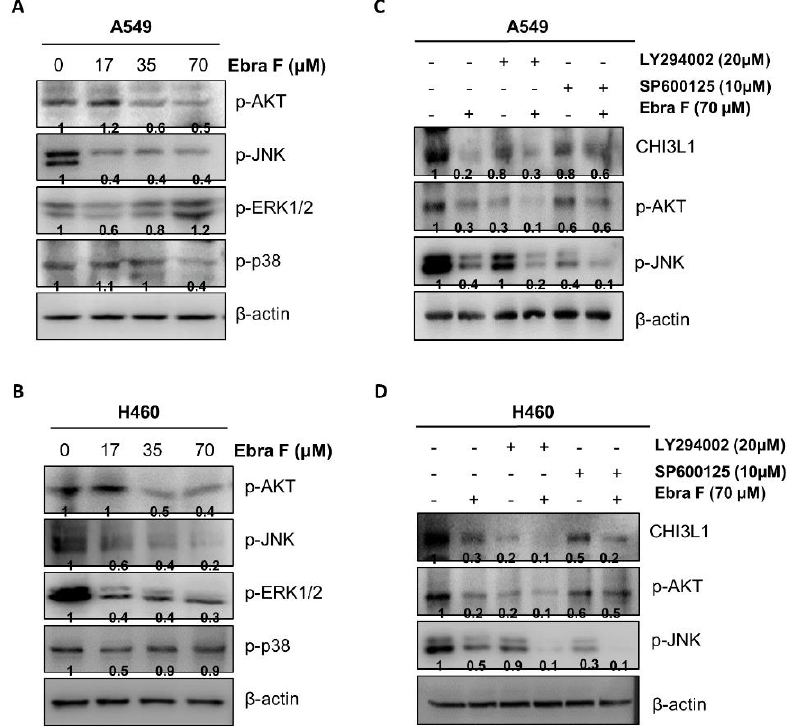
Figure 7. Combination effect of ebractenoid F with AKT inhibitor LY294002 or JNK inhibitor SP600125 on the expression of cell growth signal-associated protein. The position of CHI3L1 was important as an AKT activation site. After treating lung cancer cells with different concentration of ebractenoid F, the levels of cell growth signaling-associated proteins were determined by Western blot analysis using antibodies against p-AKT, p-JNK, p-ERK, p-p38, and β -actin (internal control) ( A , B ). A549 and H460 cells were pretreated with AKT inhibitor LY294002 (20 µ M) and JNK inhibitor SP600125 (10 µ M) for 30 min, the media were removed, and the cells were treated with ebractenoid F for 24 h ( C , D ). The expressions of CHI3L1, p-AKT, p-JNK, and β -actin (internal control) were detected by Western blotting using specific antibodies against each of these